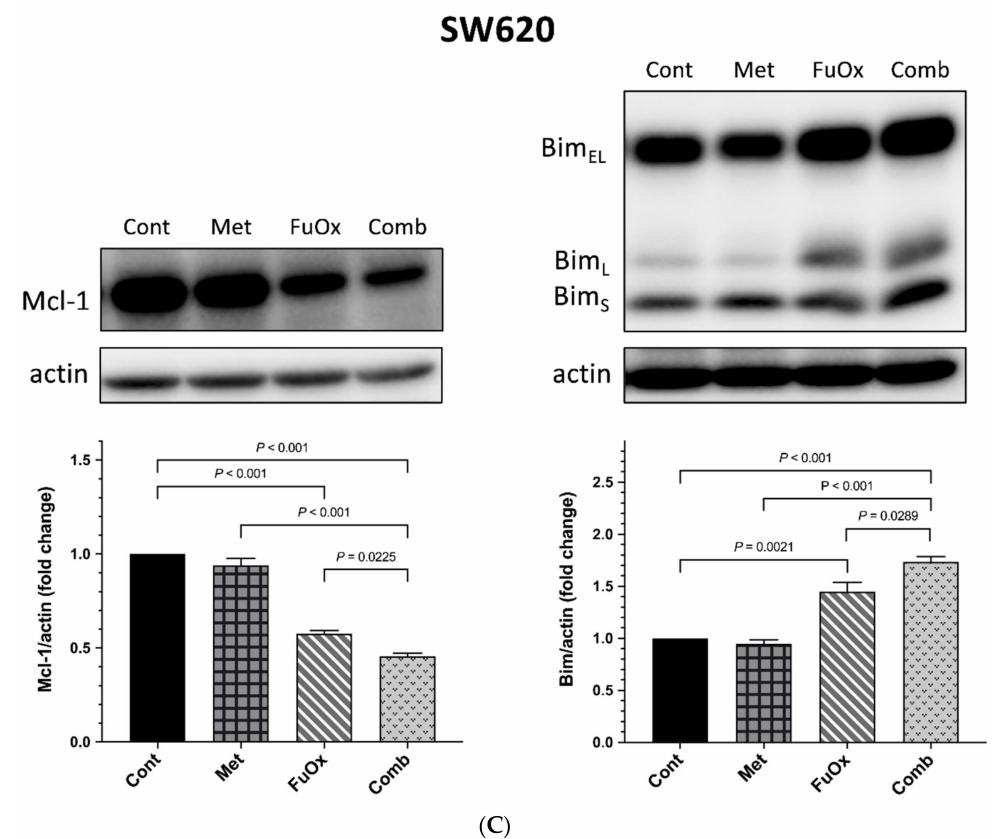
Figure 5. Metformin enhanced the expression of FuOx by modulating Mcl-1 and Bim in HT29, SW480, and SW620 cell lines. Mcl-1 and Bim protein levels in ( A ) HT29, ( B ) SW480, and ( C ) SW620 cell lines were analyzed through Western blot after 72 h treatment with metformin (5 mM), FuOx (2 µ M), and the combination of metformin and FuOx. Data are presented as mean ± SEM. Cont, control; Met, metformin; FuOx, 5FU and oxaliplatin; Comb, combination of metformin and